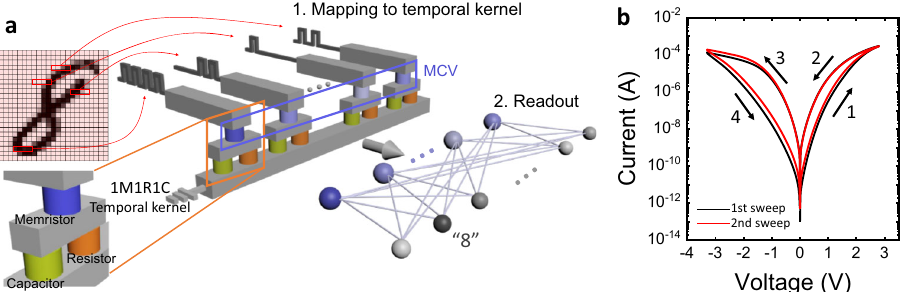
Fig. 1 The structure of the 1M1R1C temporal kernel system and the I – V characteristics of the memristor used in the temporal kernel. a The structure of the 1M1R1C temporal kernel system proposed in this study. The temporal kernel system can recognize images in the MNIST database through feature projection and classi fi cation. b The I – V curve of the W/HfO 2 /TiN memristor. The sweep order is marked in the fi gure. SET and RESET occurred in the positive bias and the negative bias, respectively, and gradual switching occurred in both switching conditions. Since the fi lament formation process is not required in this electronic switching device, no electroforming process is seen in the fi